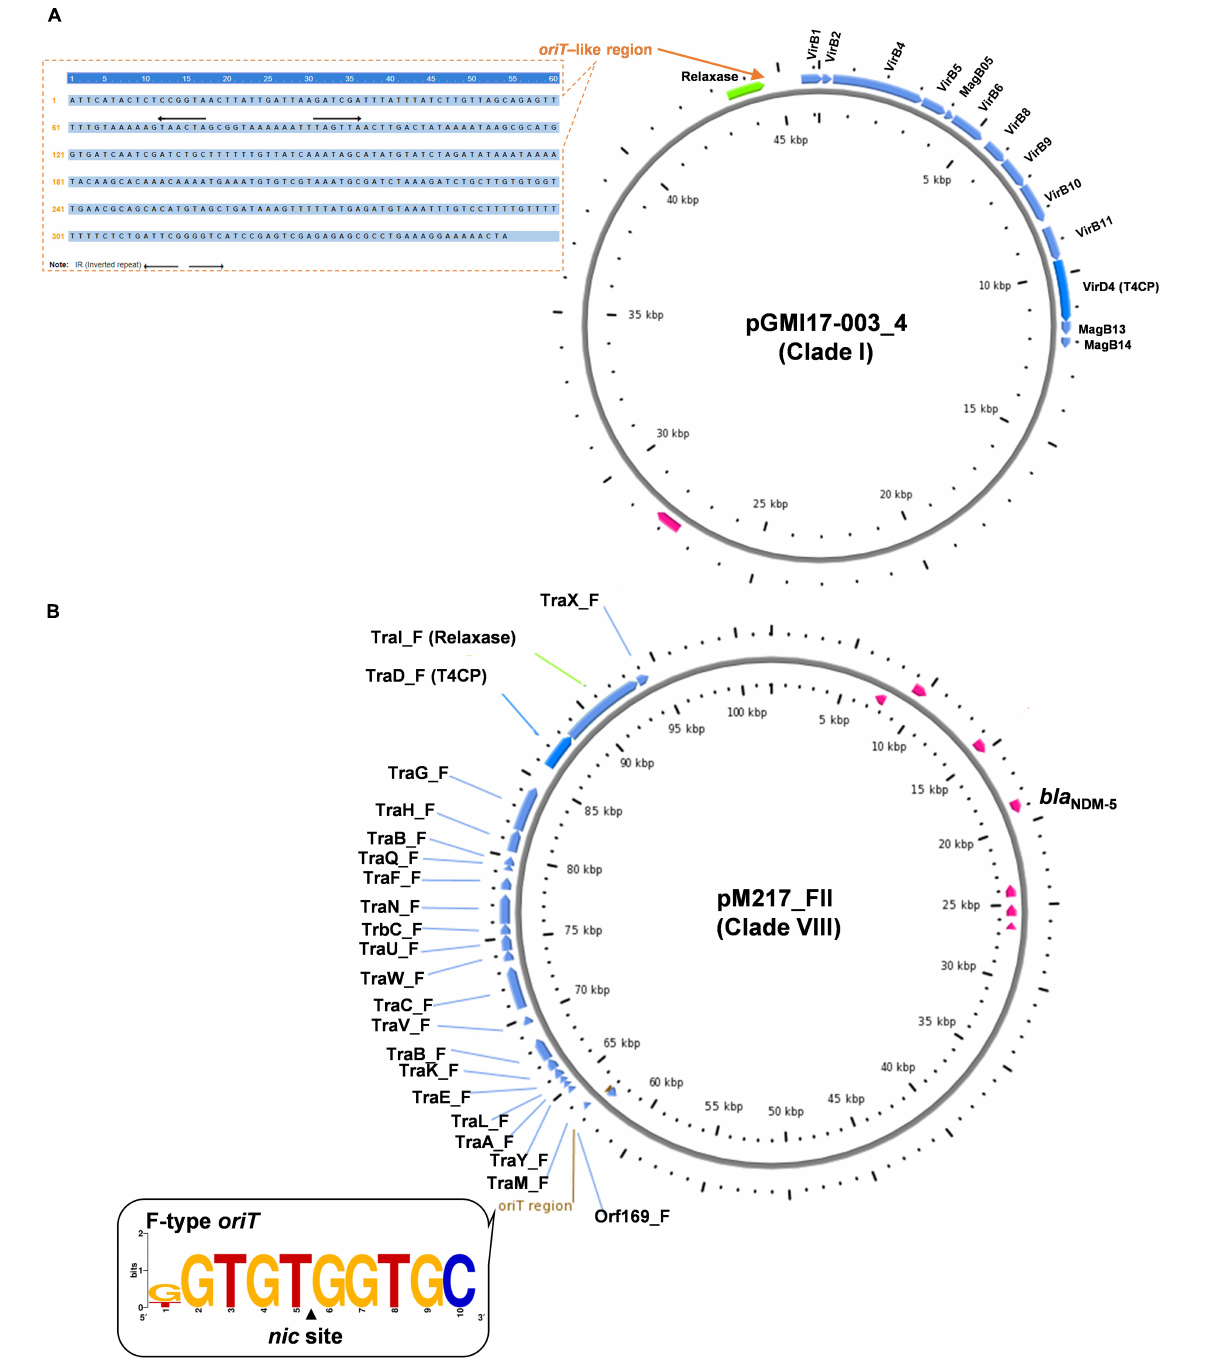
were the human origin, few were animal and environment origin ( Supplementary Table 3